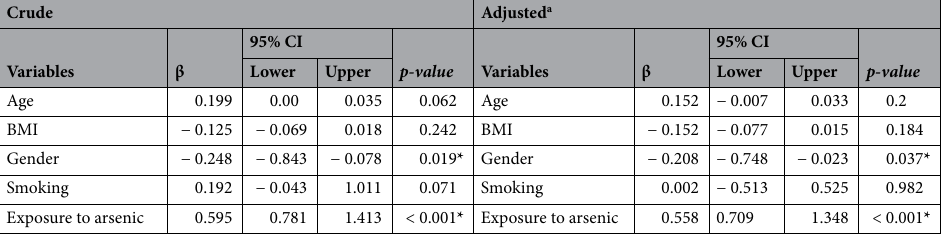
Table 3. Variables associated with the concentration of arsenic in fingernails. CI confidence interval. a Adjusted for age, gender, BMI, smoking and exposure to arsenic via drinking water. * p-value <